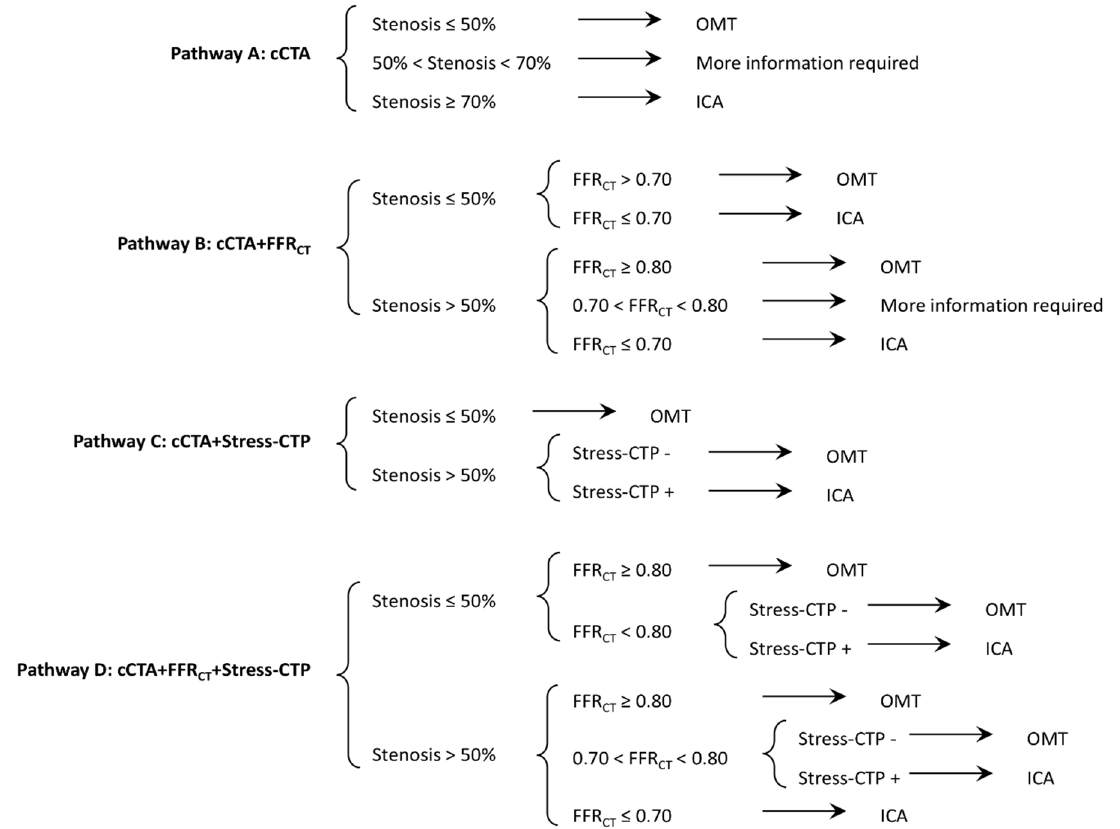
Figure 1. Clinical management algorithm. The clinical management algorithms to OMT, revascularization, or further information for cCTA alone (A), for the combined approach of cCTA + FFR CT (B), for the combined approach of cCTA + Stress-CTP (C) and for the sequential approach of cCTA + FFR CT + Stress-CTP (D) are illustrated. OMT: optimal medical treatment; cCTA: coronary computed tomography angiography; OMT: optimal medical treatment; ICA: invasive coronary angiography; FFR CT : computed tomography-derived fractional flow reserve; Stress-CTP: stress computed tomography perfusion.